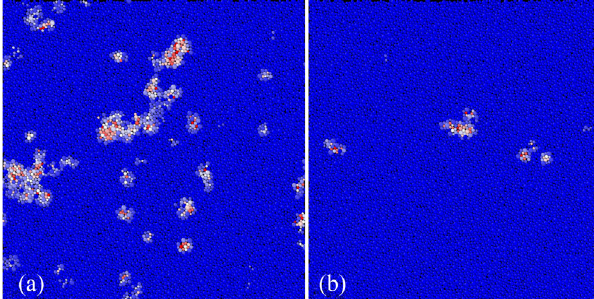
FIG. 13. Relaxed clusters at equal times in poorly aged glasses and equilibrium liquids in 2D. Snapshots of two systems simulated for t ¼ 10 7 at temperature T ¼ 0 . 075 . Initial condi- 0 . 12 , then aged T tions are (a) sample equilibrated at T i ¼ MCT ¼ 4 × 10 7 at T ¼ 0 . 075 , and (b) equilibrium sample at for t w ¼ 0 . 075 . Particles are colored following the bond-breaking T i ¼ correlation, as in Fig. 4. The linear size of the box is L ¼ 100 .